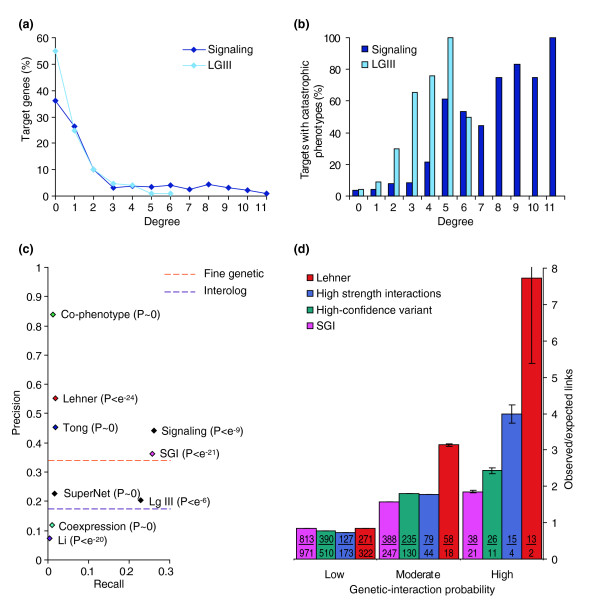
Network properties of SGI and other published datasets. (a) A plot of the percentage of targets (y-axis) that interact with a given number of query genes (x-axis), illustrating that the SGI network has properties similar to that of scale-free networks. (b) A plot of the percentage of targets that yield a catastrophic phenotype when targeted by RNAi in a wild-type background [3] (y-axis) as a function of how many query genes they interact with (degree, x-axis). (c) The precision and recall of interaction networks calculated with respect to GoProcess1000 (see Materials and methods). Significance values (in brackets) were calculated using the hypergeometric distribution. The source of the networks is presented in the text, except for the SuperNet (superimposed network, see Materials and methods). The orange dashed line indicates the precision of the fine genetic interactions extracted from WormBase. The lower dashed line indicates the precision of the interolog network (see Materials and methods). The recall of these two datasets cannot be calculated, as the number of genes that were tested cannot be ascertained. (d) An independent test of the likelihood of true interactions among the Lehner [24] and SGI genetic-interaction datasets using the algorithm of Zhong and Sternberg [44], which predicts a confidence level for a genetic interaction between any given gene pair in C. elegans. The 656 interactions of the 'high-confidence' SGI variant, along with the 229 interactions of the highest interaction strength within the SGI network are also analyzed. Each experimentally derived interacting gene pair is binned according to the confidence level predicted by Zhong and Sternberg (x-axis): low-, moderate- and high-confidence predictions have interaction probabilities of 0–0.6, 0.6–0.9, and 0.9–1.0, respectively. The results are plotted as a ratio of the number of experimentally identified interacting gene pairs to the number of gene pairs expected to be in that bin by chance (y-axis). Expected counts were determined by assuming a uniform distribution across all bins for all tested gene pairs. Values within each bar show the number of observed gene pairs over the number expected by chance. The key indicates the data source. Error bars indicate one standard error of the mean.